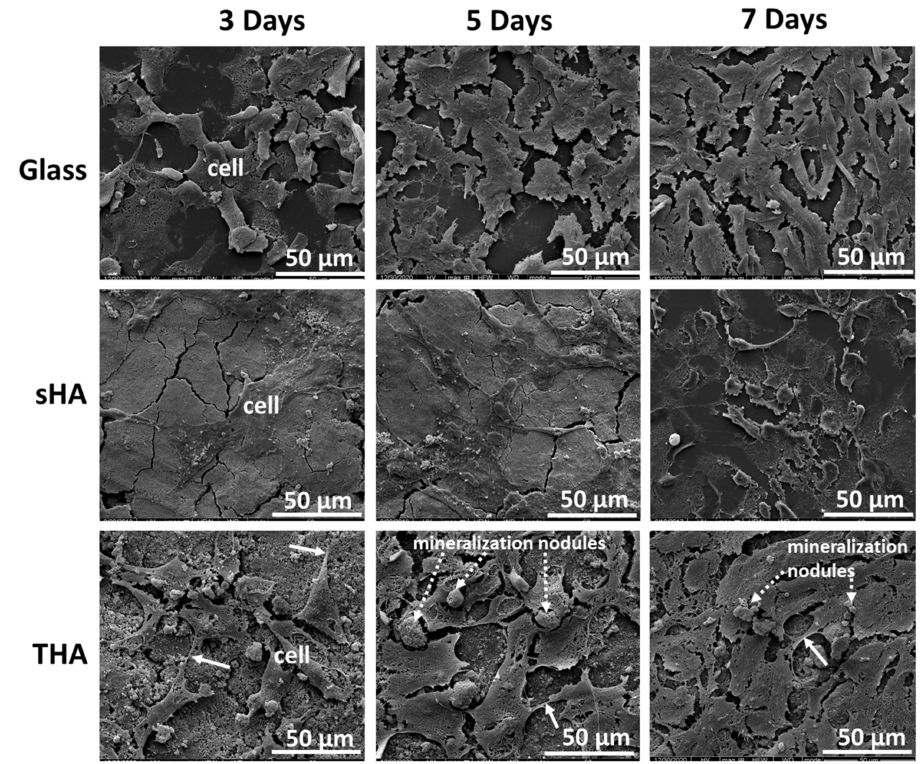
Figure 8. SEM images of osteoblast cells on glass, sHA, and THA surfaces after 3, 5, and 7 days of